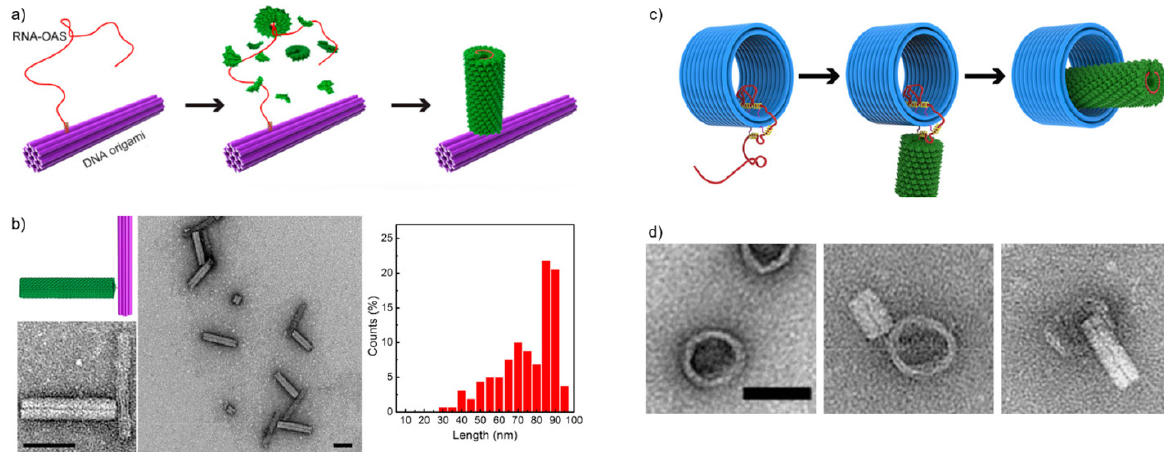
Figure 3. DNA origami-virus hybrids based on Tobacco mosaic viruses (TMV). ( a ) The in situ assembly process of TMV CPs around a TMV RNA strand anchored to a DNA origami platform [41]. The origin of assembly (OAS) sequence nucleates the growth of the nanotube. ( b ) Assembled TMV-DNA origami hybrids viewed with TEM. The graph on the right shows the length distribution of assembled tubes around a ~1910-nt long RNA. Scale bars are 50 nm. ( c ) The in situ assembly of a TMV rod nestled inside a DNA origami barrel [45]. The assembly is guided by pathing the RNA strand through multiple binding sites along the DNA origami and then releasing the bound RNA in a stepwise manner. The DNA origami barrel was a 23-helix bundle with a length of ~30 nm and an inner diameter of ~34 nm. ( d ) TEM images of the steps depicted in Figure 3c. Left: the DNA origami barrel with pathed RNA. Middle: CP rod assembly on the unbound overhang of the RNA. Right: A finished CP rod inside the hollow of a DNA origami barrel. Scale bar is 50 nm. ( a , b ) reproduced with permission from [41]. Copyright American Chemical Society, 2018. ( c , d ) reproduced with permission from [45]. Copyright American Chemical Society, 2020.